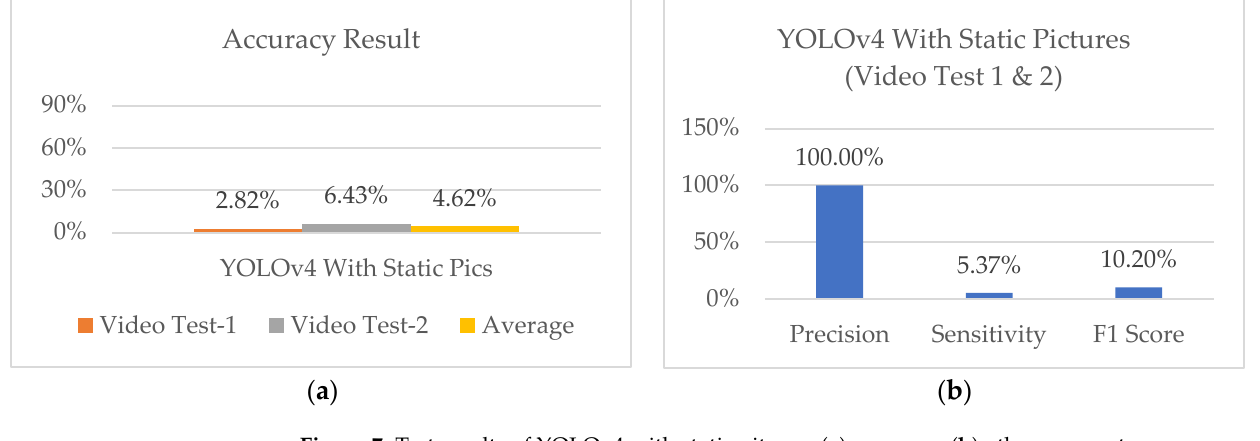
Figure 7. Test results of YOLOv4 with static pitures: ( a ) accuracy; ( b ) other parameters.